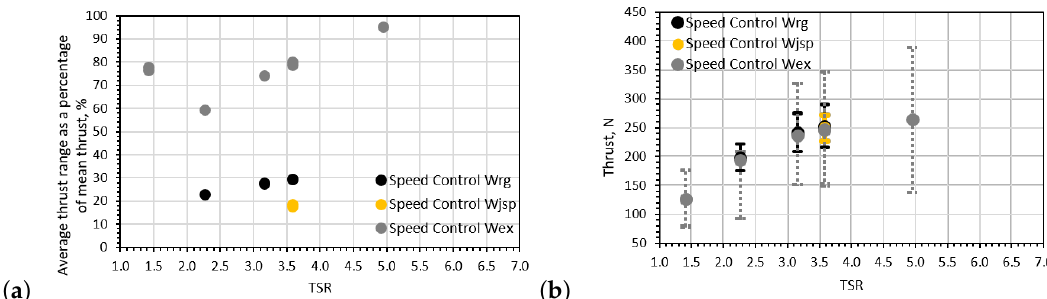
Figure 12. Average rotor thrust fluctuations per wave period only for speed control cases: ( a ) the thrust fluctuation range as a percentage of the mean rotor thrust for each case is presented and ( b ) the average maximum and minimum rotor thrust per wave period are indicated by the extremes of the error